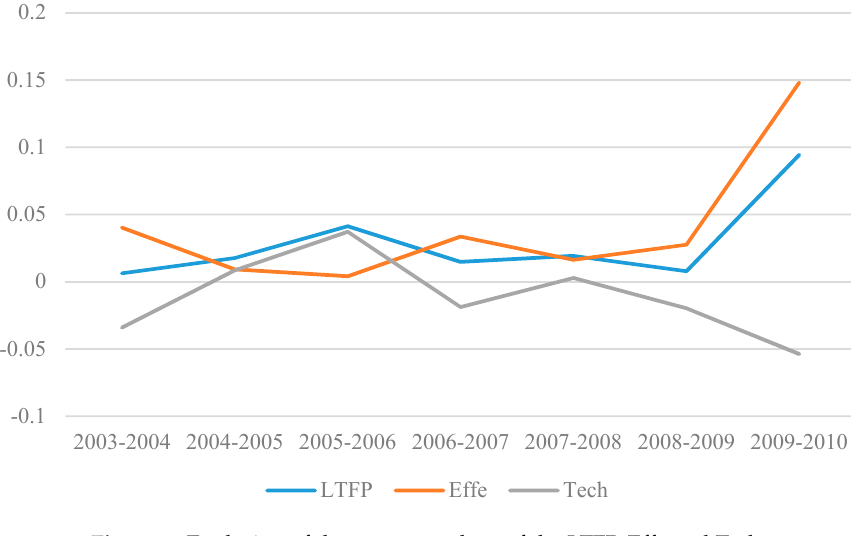
Figure 1. Evolution of the average values of the LTFP, Effe and Tech.